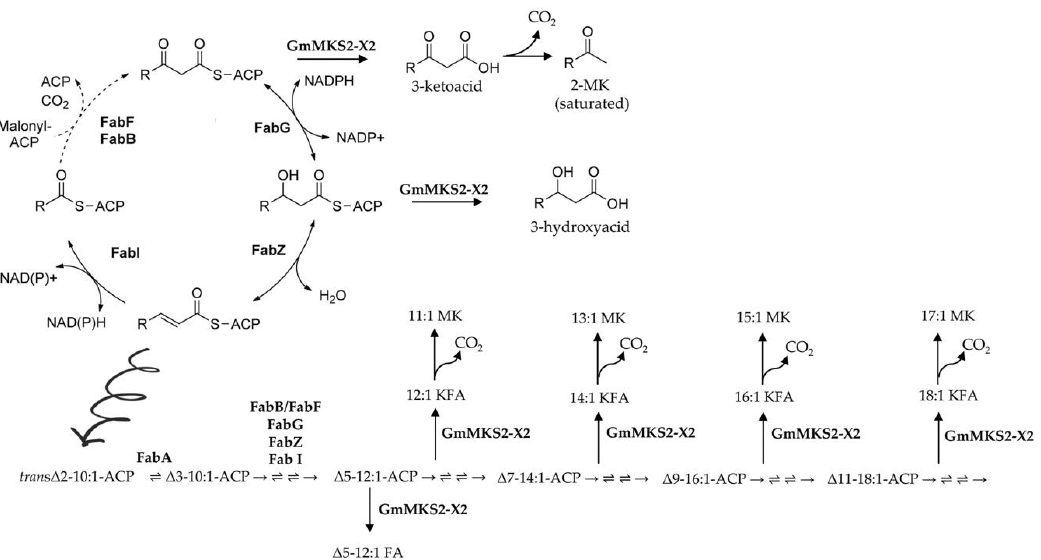
Figure 6. GmMKS2-X2 acts on a broad range of acyl-ACPs, intermediates in fatty acid biosynthesis in E. coli . Unsaturated fatty acid biosynthesis in E. coli begins with the isomerization of trans -2-decenoyl- in E. coli ACP to cis -3-decenoyl-ACP by FabA. This intermediate is then condensed with malonyl-ACP by FabB instead of being reduced. The resulting unsaturated β-ketoacyl-ACP is processed similar to its saturated counterpart, until unsaturated C 16 and C 18 acyl-ACPs are made and incorporated into phospholipids. The compounds 2-methylketone, 3-keto fatty acid, and fatty acid are denoted as MK, KFA, and FA, respectively. The arrows between each intermediate denote, in order, 3-ketoacyl-ACP synthase (FabB or FabF), 3-ketoacyl-ACP reductase (FabG), 3-hydroxyacyl-ACP dehydratase (FabZ), and enoyl-ACP reductase (FabI).